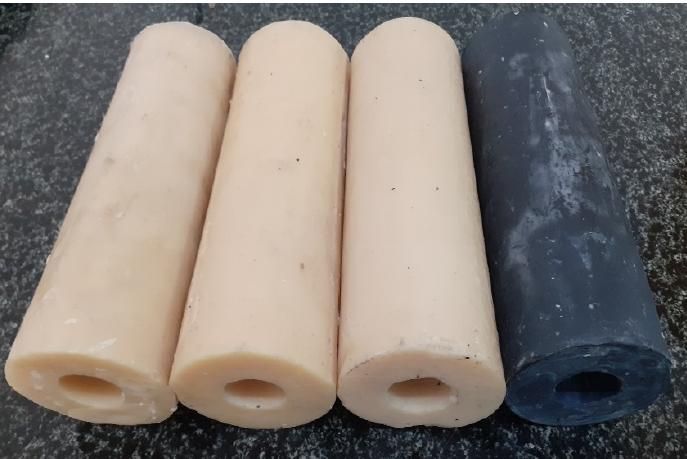
Figure 2. Beeswax–EVA-based solid fuel grains after